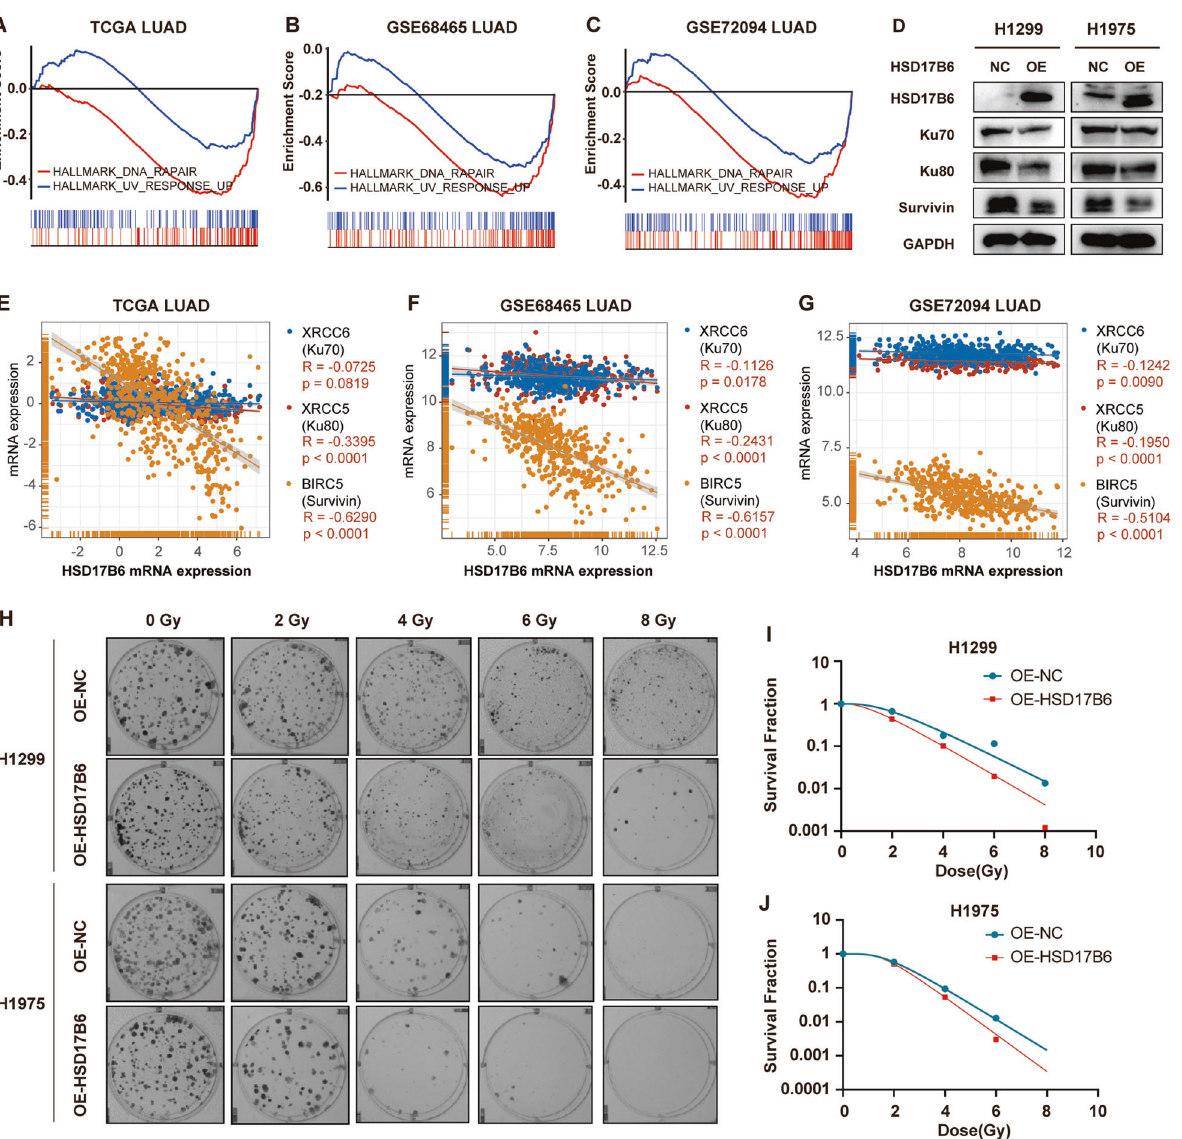
Fig. 7 HSD17B6 reduces radioresistance in lung cancer cells. A – C GSEA analysis revealed that HSD17B6 expression levels were negatively correlated with gene signatures of “ HALLMARK DNA REPAIR ” and “ HALLMARK UV RESPONSE UP ” in TCGA LUAD, GSE68465, and GSE72094 datasets. D Protein levels of Ku70, Ku80, and Survivin were assessed by western blotting after HSD17B6 overexpression. E – G Correlation analysis of HSD17B6 expression and expression of DNA repair/survival-related genes (XRCC6, XRCC5, and BIRC5) in TCGA LUAD, GSE68465, and GSE72094 datasets. H Clonogenic survival of H1299 and H1975 following radiation. I Cell survival curves of H1299 OE-NC (blue line) and H1299 OE-HSD17B6 cells (red line) were plotted by the multi-target single-hit model. J Cell survival curves of H1975 OE-NC (blue line) and H1975 OE-HSD17B6 cells (red line) were plotted by the multi-target single-hit